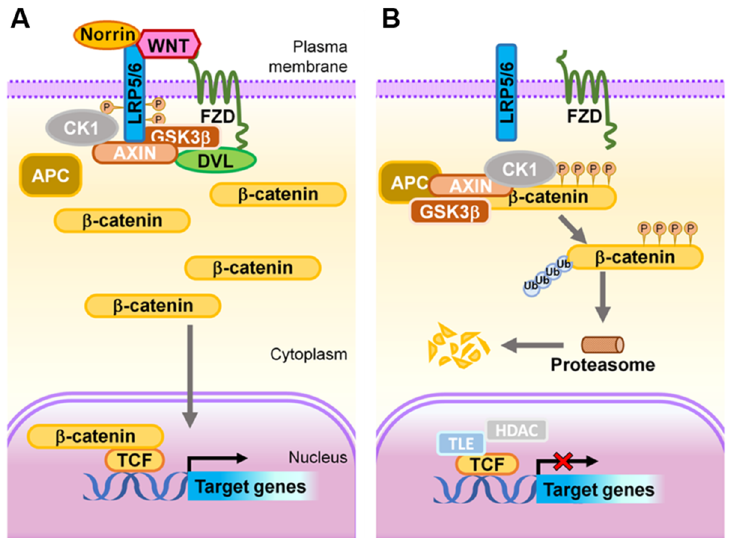
Figure 4. Schematic representation of the Wnt signaling transduction cascade. ( A ) ON state: In the presence of Wnt ligands or Norrin, LRP5/6 is recruited into the receptor complex with Wnt- or Norrin-bound FZD, which further recruits DVL proteins, resulting in subsequent phosphorylation of LRP5/6 by GSK3 and CK1, and Axin on-boarding. The destruction of APC/Axin/GSK3 β complex prevents phosphorylation of β -catenin, hence allowing its stabilization and accumulation within the cytoplasm. The stabilized β -catenin subsequently translocates into the nucleus where it binds to LEF/TCF transcription factors to transactivate expression of Wnt target genes. ( B ) OFF state: In the absence of a Wnt ligand, or when it is inhibited from binding to FZD and LRP5/6, the APC/Axin/GSK3 β complex and CK1 synergistically target cytoplasmic β -catenin for phosphorylation, ubiquitination, and subsequent proteasomal degradation. As a result, in this ‘off’ state, transcription of Wnt signaling responsive genes is attenuated by TCF-TLE1/Groucho and HDAC. APC, adenomatous polyposis coli; CK1, casein kinase 1; DVL, Dishevelled; FZD, Frizzled; GSK3, glycogen synthase kinase 3; HDAC, histone deacetylases; LRP, low-density lipoprotein receptor-related protein; TCF, T cell factor; TLE1, transducing-like enhancer of split-1. Figure adapted with permission from Wang, et al., Prog Retin Eye Res . 2019.